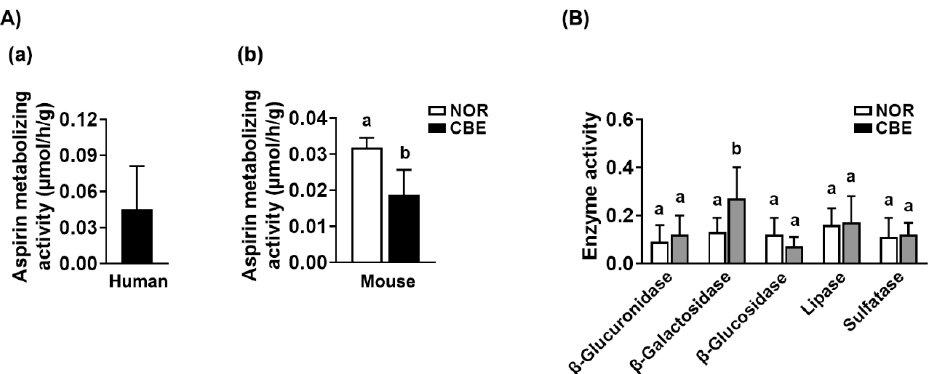
Figure 3. The enzyme activities of human and mouse fecal samples. ( A ) The fecal aspirin-metabo- lizing activities. ( a ) The fecal aspirin-metabolizing activities of humans. (b) The fecal aspirin-metab- olizing activities fo mice treated with coffee bean extract (CBE) or vehicle (NOR) ( b ). ( B ) The β - glucuronidase, β - galactosidase, β -glucosidase, lipase, and sulfatase activities were analyzed in the feces of mice with CBE or vehicle. Data are shown as the mean ± S.D. ( n = 6). Means with same letters are not significantly different ( p < 0.05).